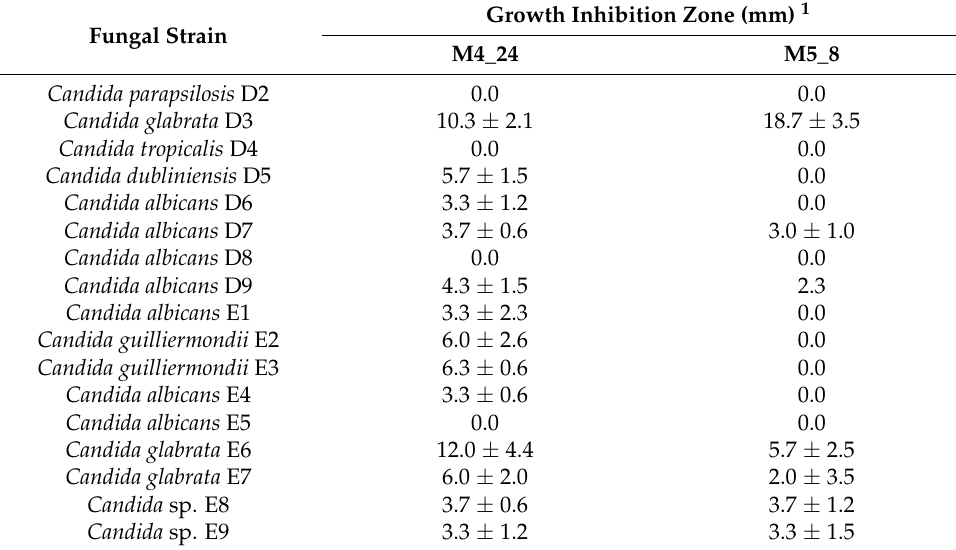
Table 4. Effects of Streptomyces M4_24 and M5_8 isolates on growth inhibition of fungal strains. The width of the inhibition zone was measured in the streak-test after 48 h of